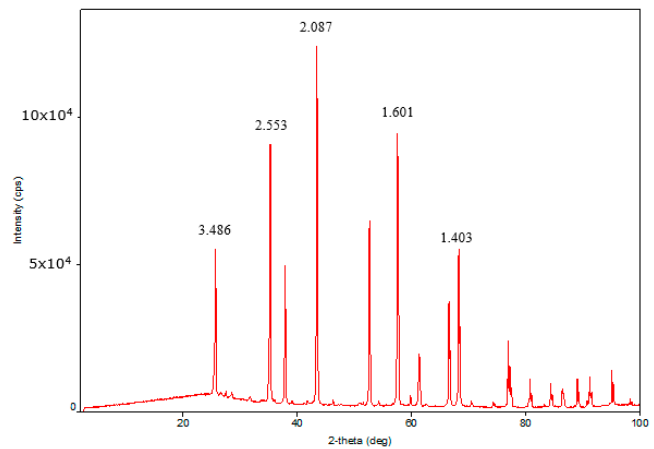
Figure 2. XRD pattern of highly porous support.